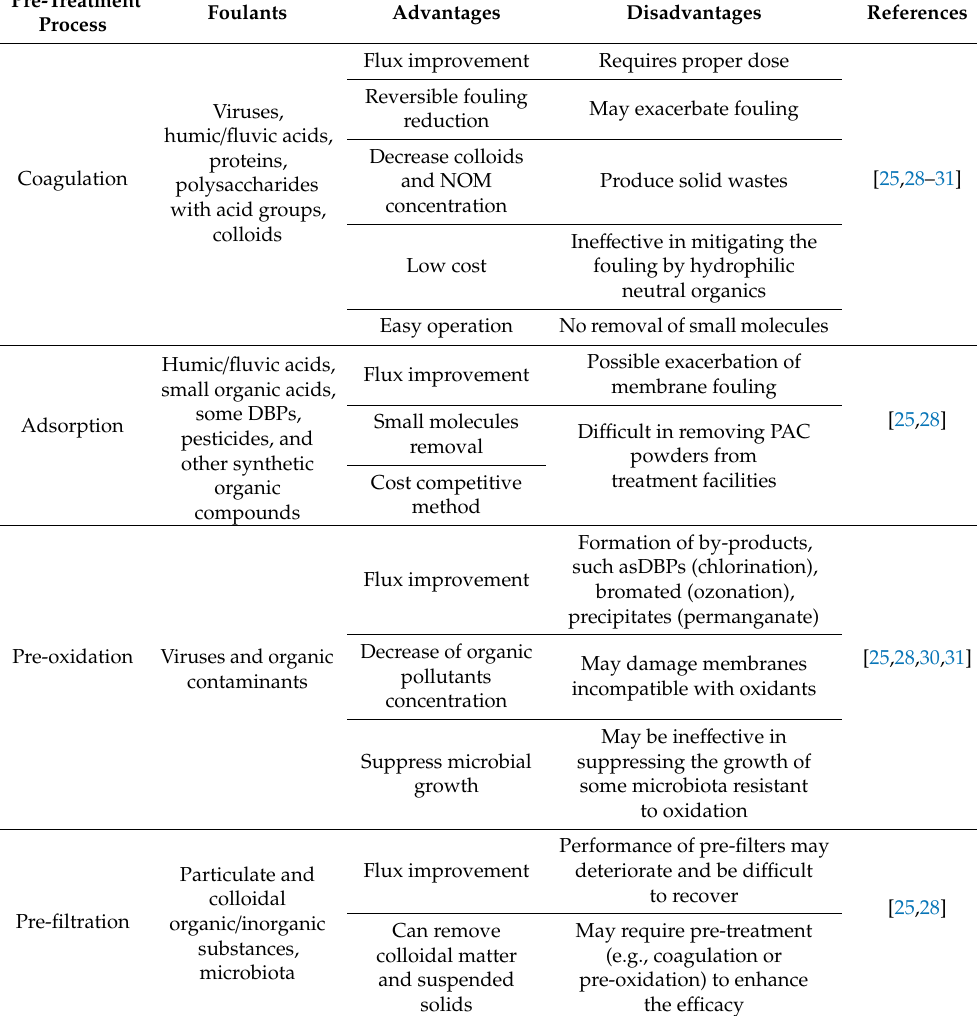
Table 2. Main pre-treatment processes applicable for fouling control: major applications, advantages, and